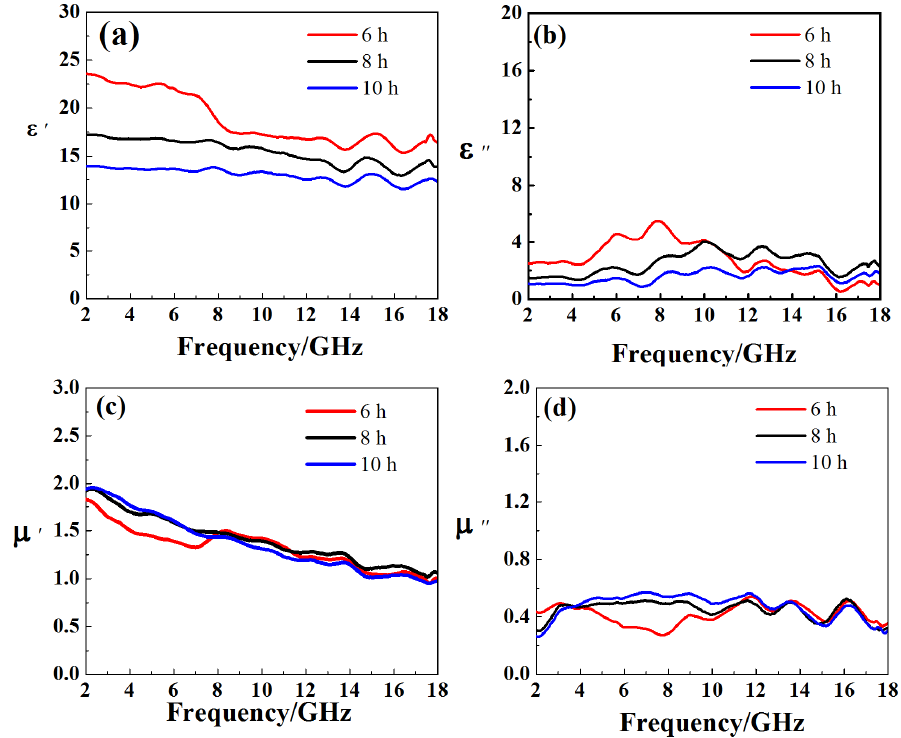
Figure 6. The ε ’ ( a ), εʺ ( b ) μ (cid:4593) ( c ) and μʺ ( d ) of samples with different milling time. Figure 6. The ε (cid:48) ( a ), ε (cid:48)(cid:48) ( b ) µ (cid:48) ( c ) and µ (cid:48)(cid:48) ( d ) of samples with different milling